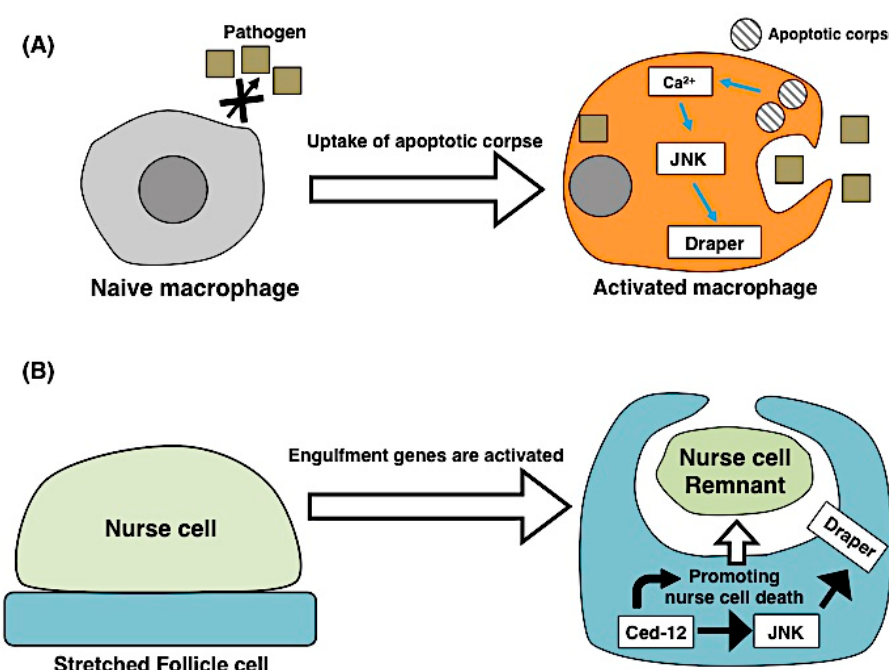
Figure 2. The mutual interaction between apoptotic cells and engulfing cells: ( A ) The process of macrophage priming. Naive macrophages cannot engulf pathogens. Apoptotic cells induce the non-autonomous activation of macrophages, and uptake of these cells leads to their transformation into mature macrophages; ( B ) Model for NC death in Drosophila oogenesis. Stretch follicle cells (FCs) contact nurse cell (NC) remnants during late oogenesis and non-autonomously promote NC death. In stretched FCs, the engulfment gene Draper becomes activated by the Ced-12-JNK signal. Ced-12 also contributes to NC death in parallel with the JNK-Draper pathway.